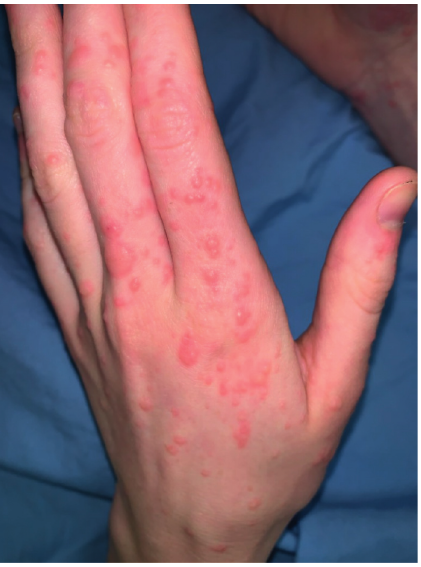
Figure 2: Dorsum of the left hand.